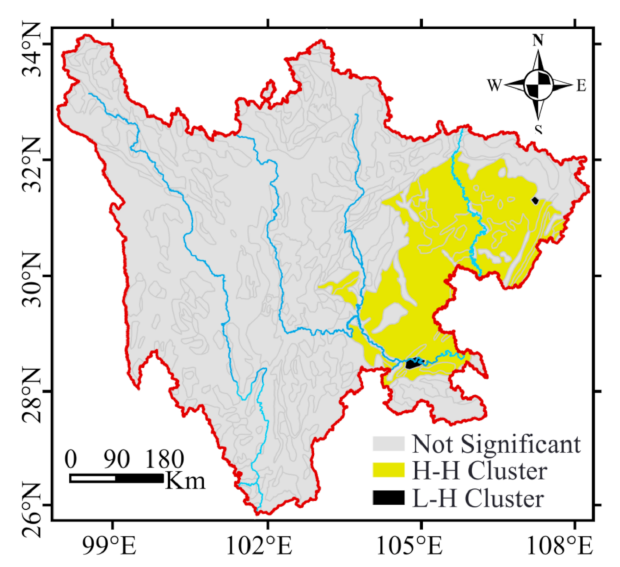
Figure 4. Clustering characteristics of cultivated land geomorphic